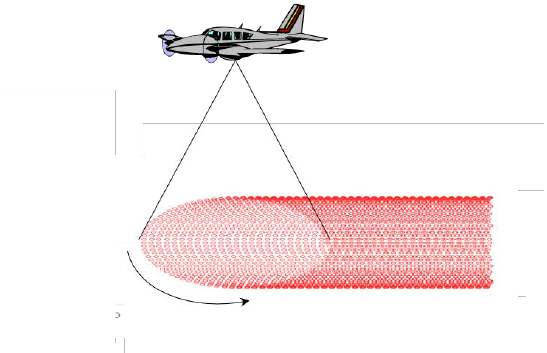
Figure 3: Conical LiDAR scan